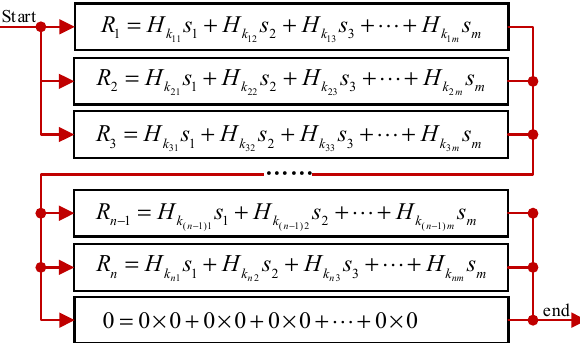
Figure 5. Autonomous operation process of matrix-vector multiplication. According to the autonomous operation process, the data of the m × n coefficient matrix of H k show the law of sequential reading. The multiplied vector s is read sequentially within row operations and circularly between row operations. If the data in Equation (7) can be stored in sequence according to the operation flow of Figure 5, the data search in the autonomous operation of the matrix-vector multiplication task can be realized by providing several first addresses at startup. The data storage and addressing process of Equation (7) is shown in Figure 6a. The coefficient matrix is only used inside the algorithm modularization architecture, so it is stored in the local RAM, and because of the parallel calculation of three row operations, local RAM is set as vector memory, read and write in SIMD mode. Most multiplied vectors need to communicate with the outside, so they are stored in the shared RAM. The multi- plied vector of each row operation is the same, shared RAM is set as scalar memory. The ( ) t x can be completed by providing coeffi- i and autonomous operation of tasks ( ) t int s